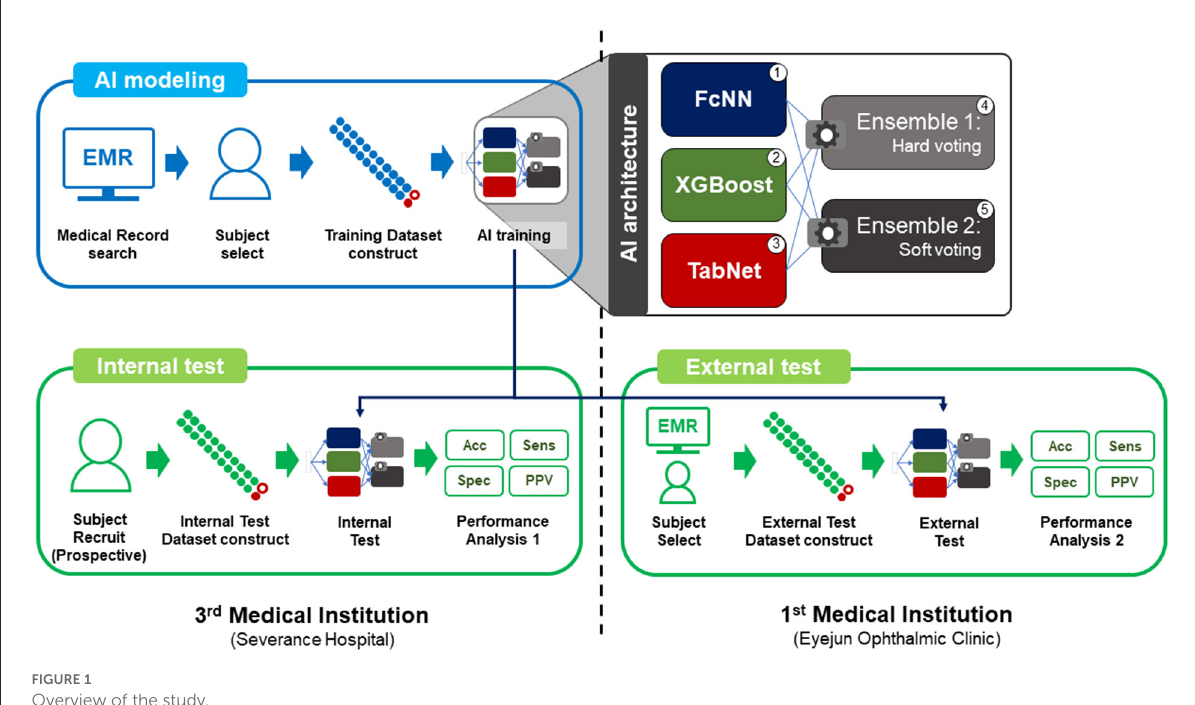
FIGURE1 Overview of the